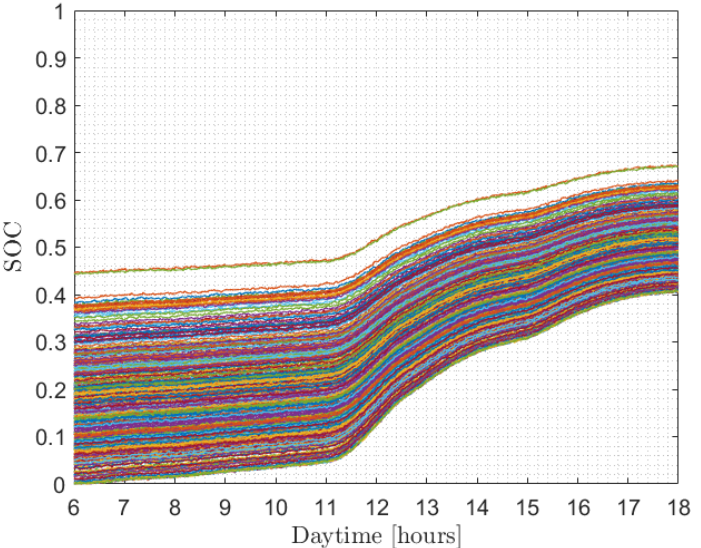
Figure 6. Individual SOCs of a fixed population of 400 BEVs in the sunny day.